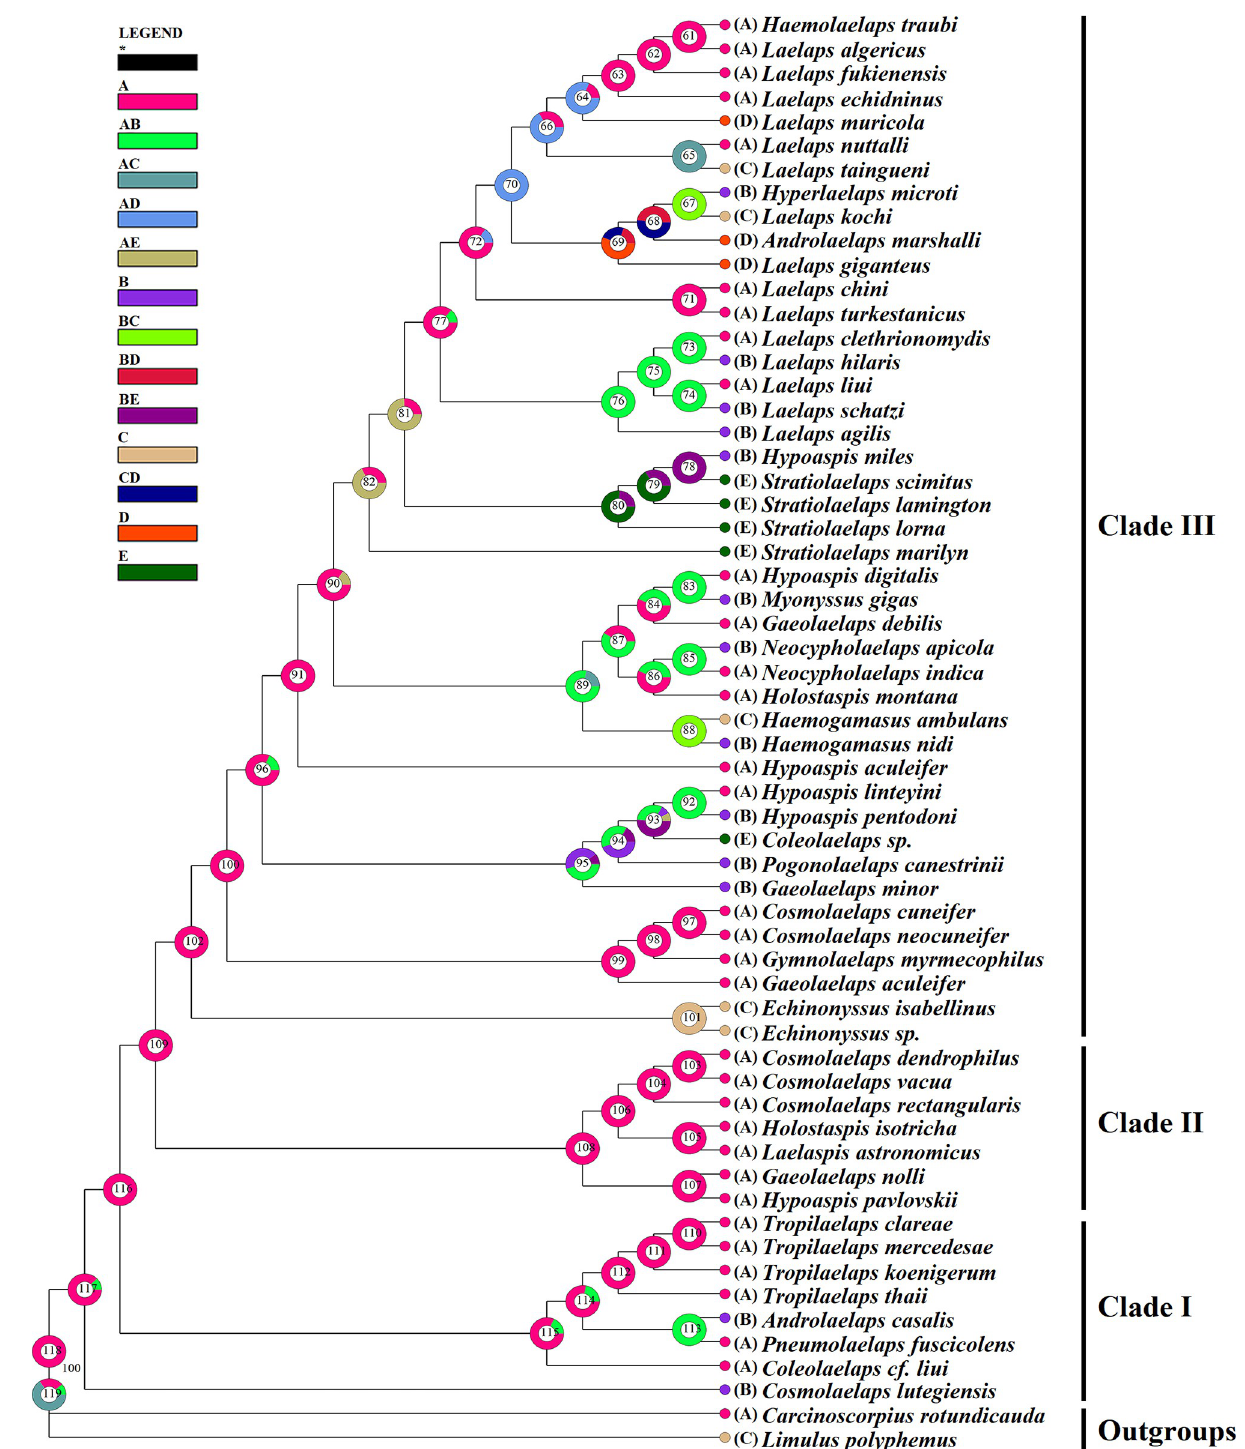
Fig 6. Graphical output of the ancestral distribution of the family Laelapidae obtained using the Dispersal-Extinction-Cladogenesis (DEC) method (exported from RASP). The colors of different nodes represent the range of possible ancestors.